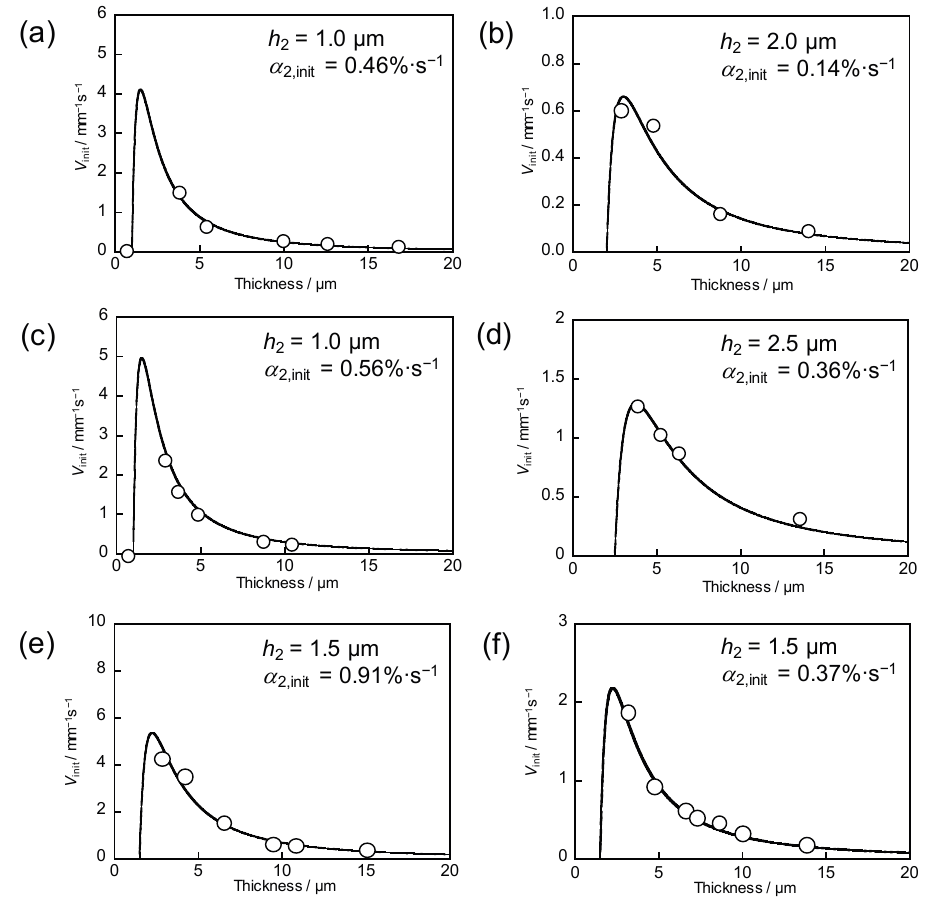
Figure 2. Initial speed of the curvature change relative to the crystal thickness in diarylethene crystals ( a ) 1 ; ( b ) 2 ; ( c ) 3 ; ( d ) 4 ; ( e ) 5 ; and ( f ) 6 . The solid lines show fitting curve using the bimetal